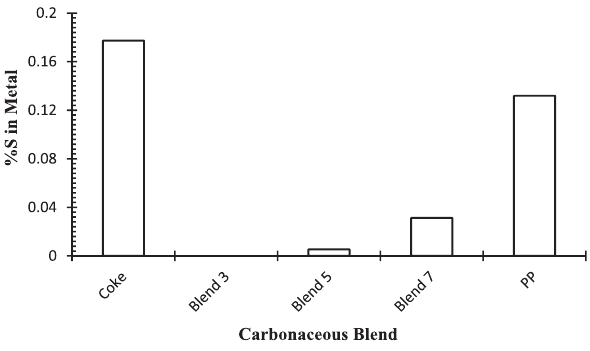
Fig. 12: Content of sulphur in the reduced metal after reduction of FeO in slag by various reductants at 1500